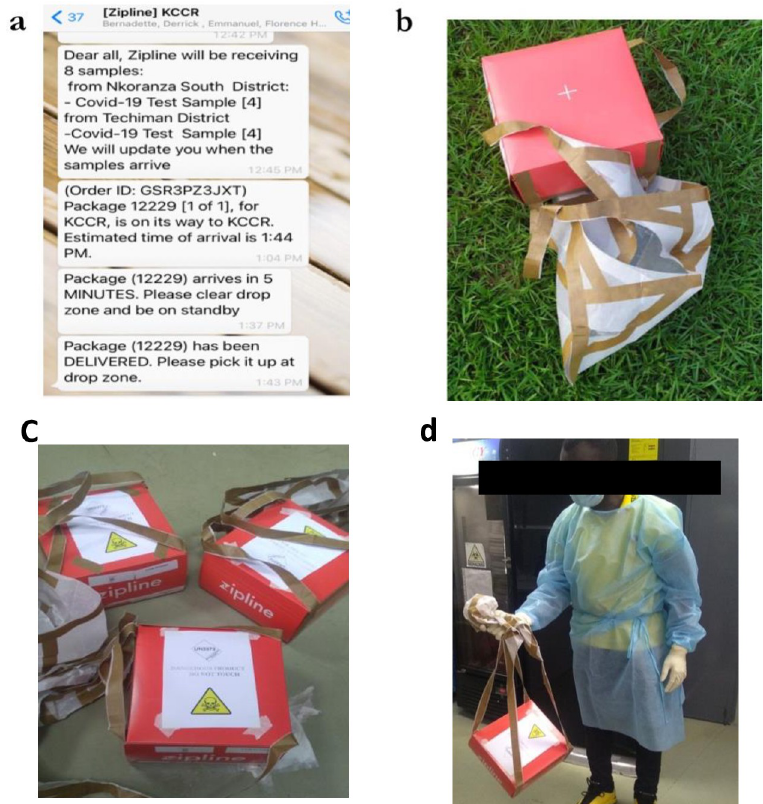
Fig 2. a : WhatsApp chat message with information on samples being sent to the testing Centre; b : Package with sample at the drop zone yet to be picked up by testing team c : Sample packages transported to the laboratory for analysis d : Sample receiving team member transporting sample to the